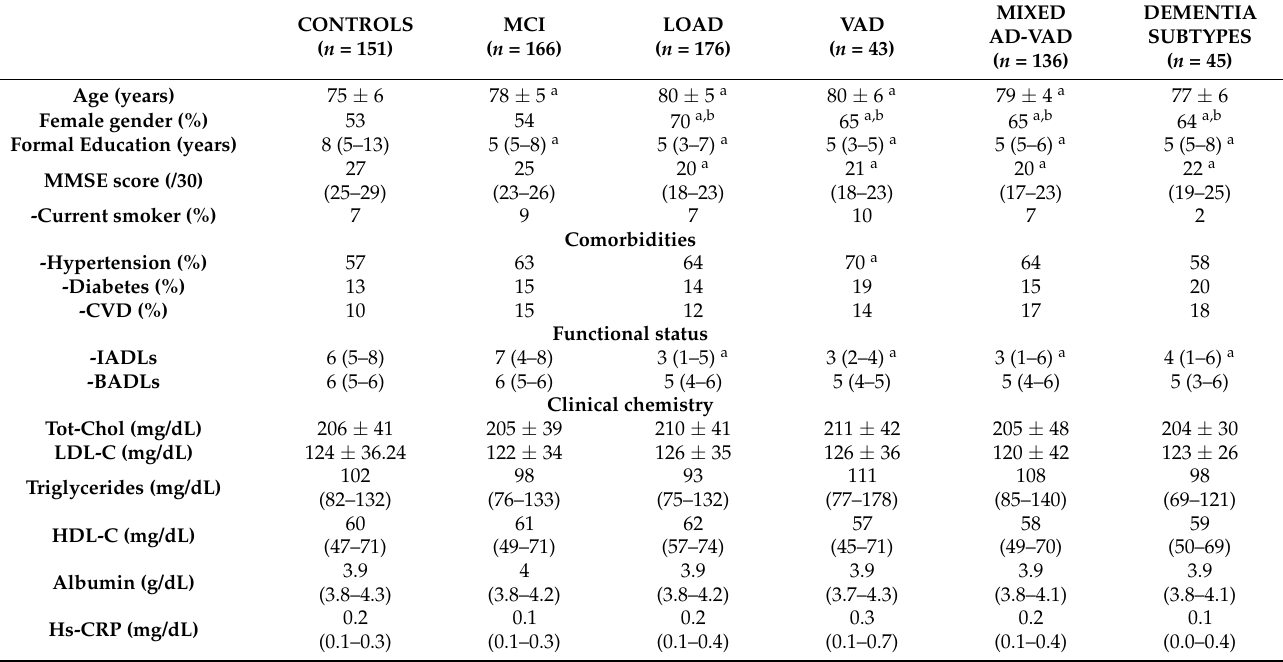
Table 1. Main characteristics of the sample according to